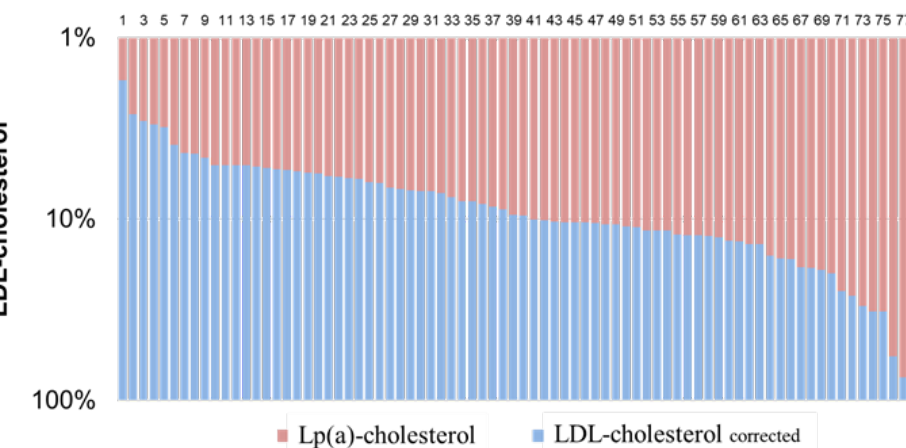
Figure 3. Contribution of lipoprotein(a) to the concentration of low-density lipoprotein cholesterol in patients with hyperlipoproteinemia(a) and familial hypercholesterolemia.